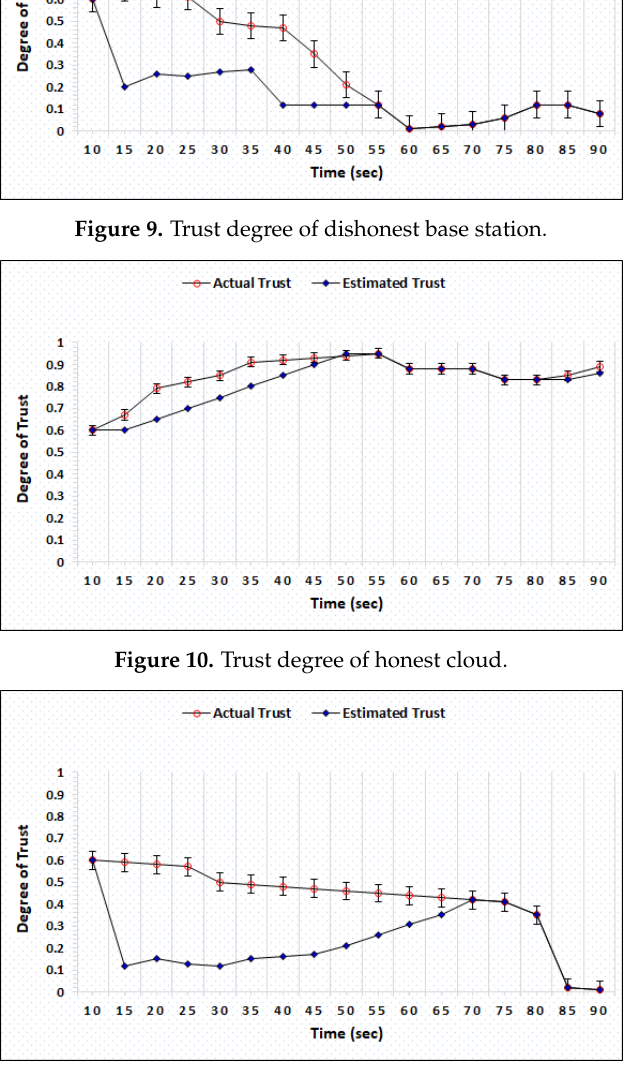
Figure 11. Trust degree of dishonest